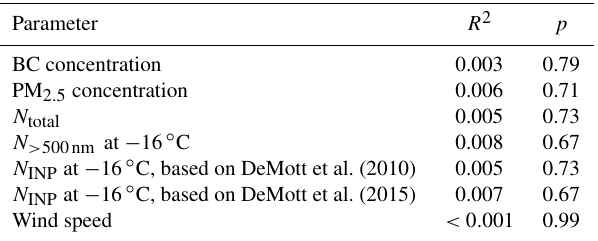
Table 1. Coefficient of determination ( R 2 ) and a measure for the statistical significance of the assumption of a linear correlation ( p ) for the comparison of N INP at − 16 ◦ C with the different parameters shown in Fig.